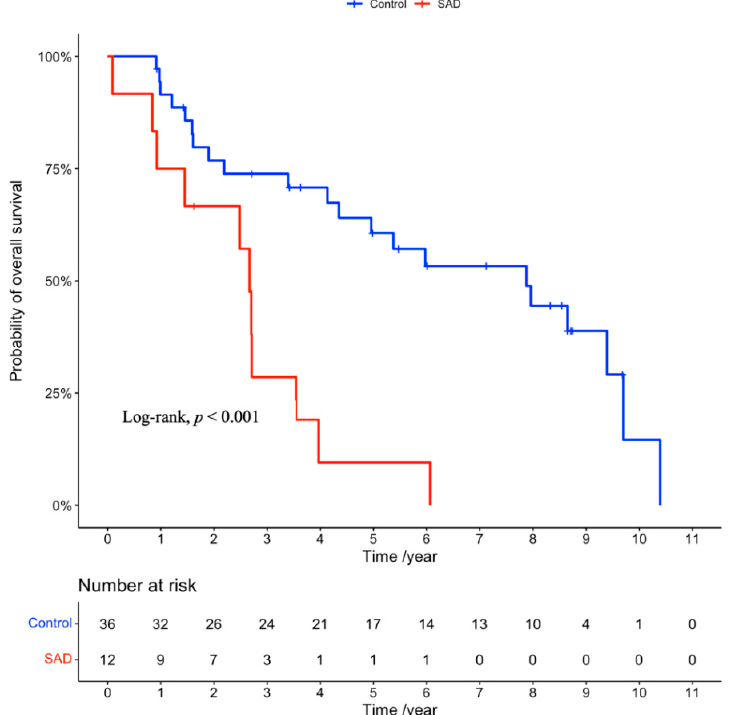
Figure 1. Kaplan–Meier curves for overall survival in the SAD and control groups. SAD: systemic autoimmune disease.